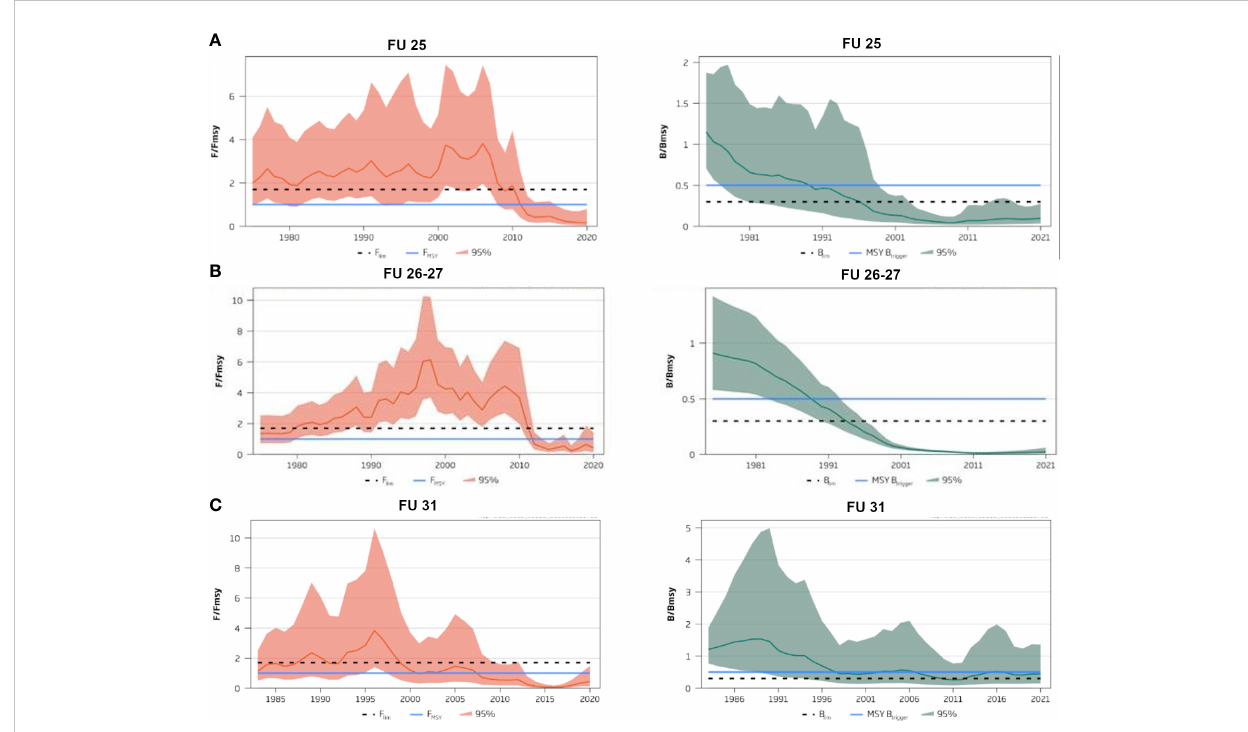
FIGURE 3 Nephrops relative fi shing mortalities and biomasses. FU 25 (North Galicia) (A) , FU 26-27 (West Galicia and North Portugal) (B) and FU 31 (Cantabrian Sea) (C) (ICES, 2021b; ICES, 2021c; ICES, 2021d). B trigger =0.5 x B MSY , B lim =0.3 x B MSY , F lim =1.7 x F MSY .